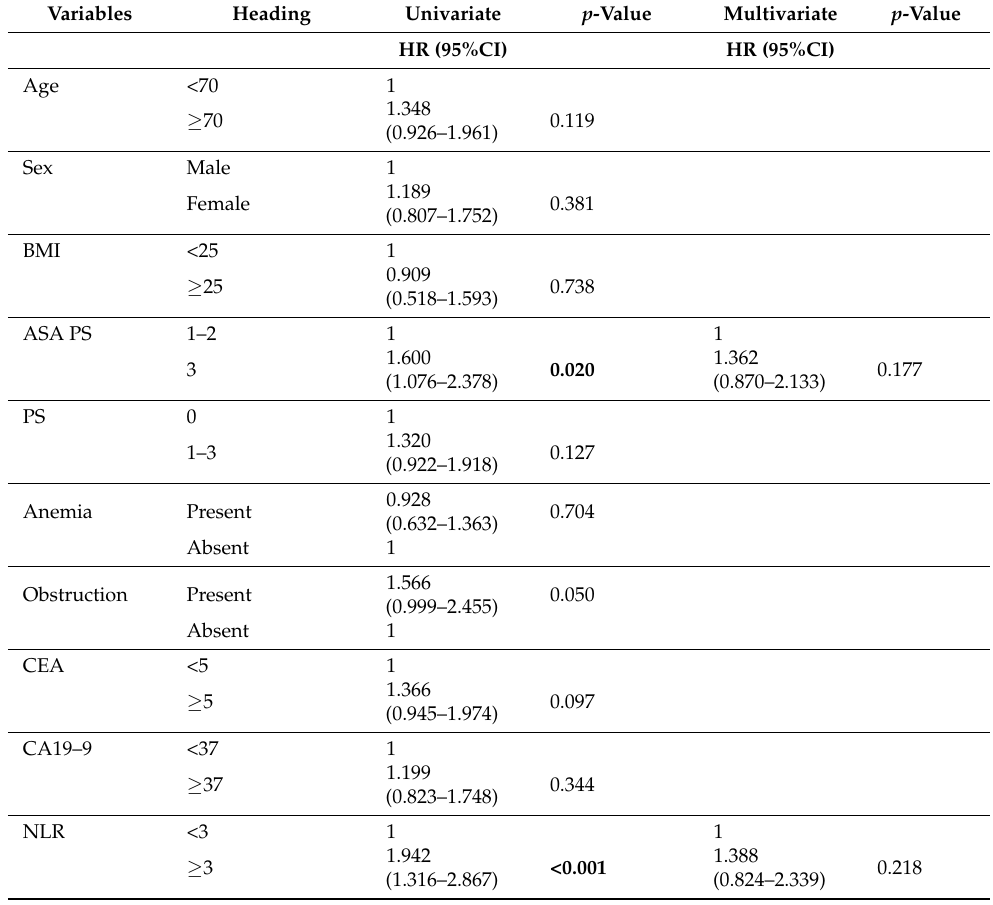
Table 2. Univariate and multivariate analysis of overall